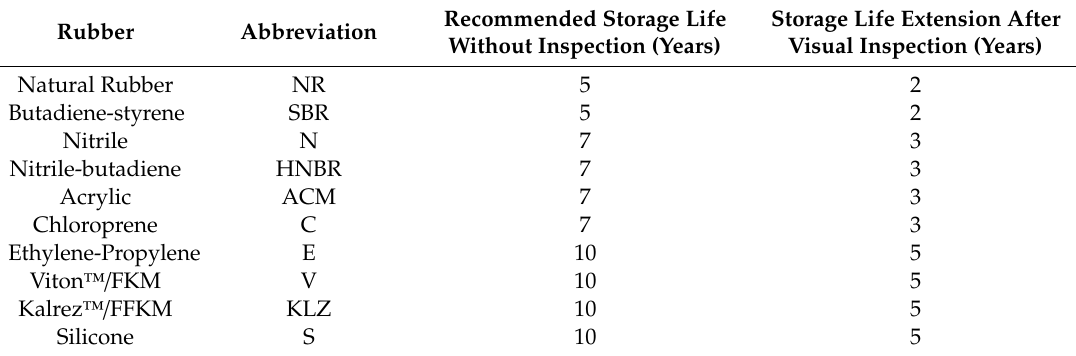
Table 1. Shelf life of products made out of di ff erent types of rubber